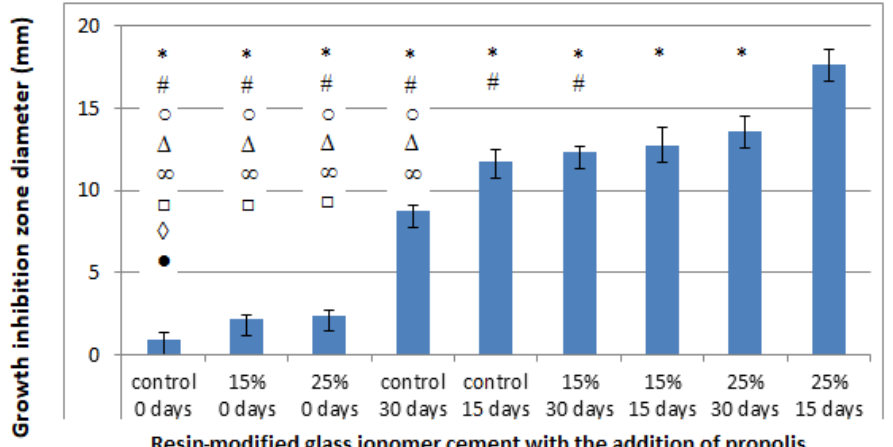
Figure 5. The graph of Mann-Whitney test result between adhesive materials. Note : Statistically significant (p<0.05). * = < 25% 15 days, # = < 25% 30 days, ○ = < 15% 15 days, ∆ = < 15% 30 days, ∞ = < control 15 days, □ = < control 30 days, ◊ = < 25% 0 days, ● = < 15% 0 days.